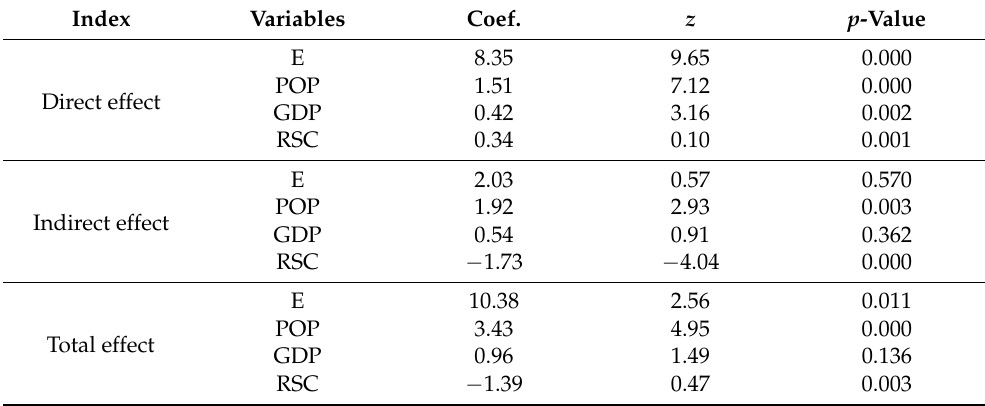
Table 4. Decomposition of spillover